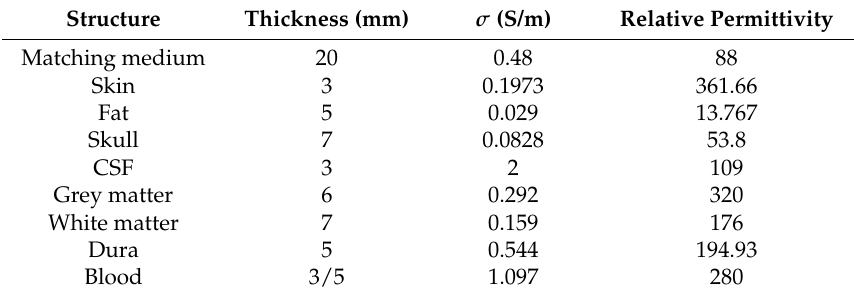
Table 1. EPs of tissues at 10 MHz [34].